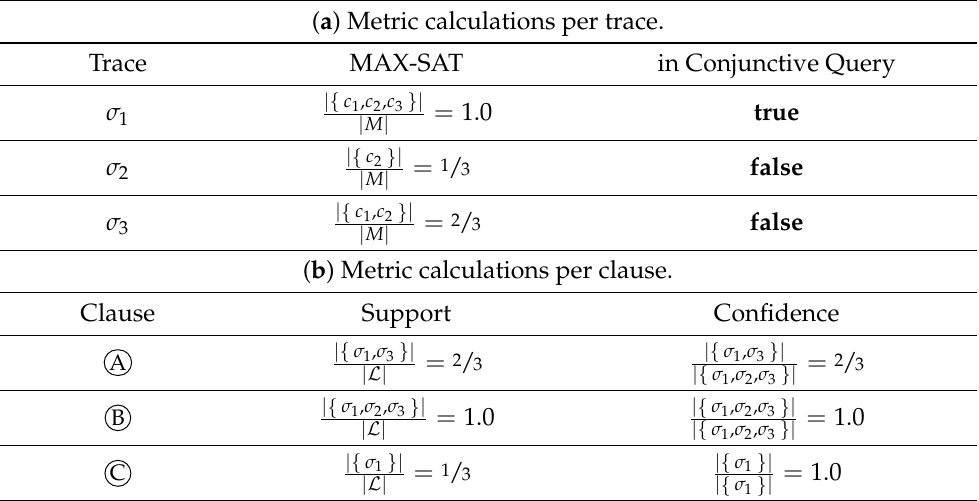
( b ) Metric calculations per